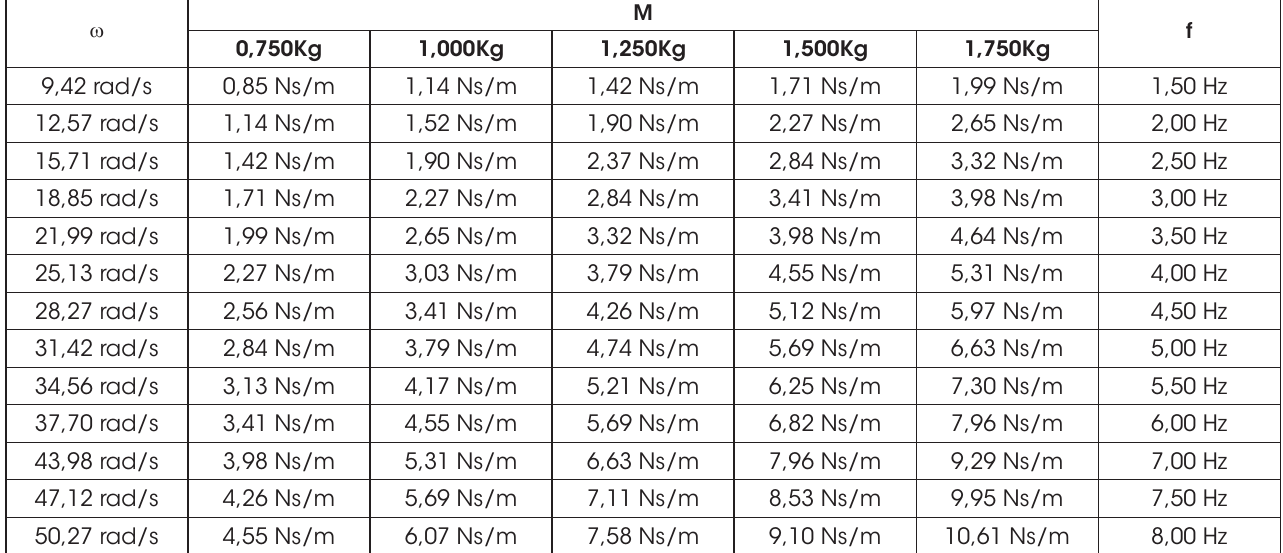
Ideal damping coefficient for the considered spring-frequency combinations ω